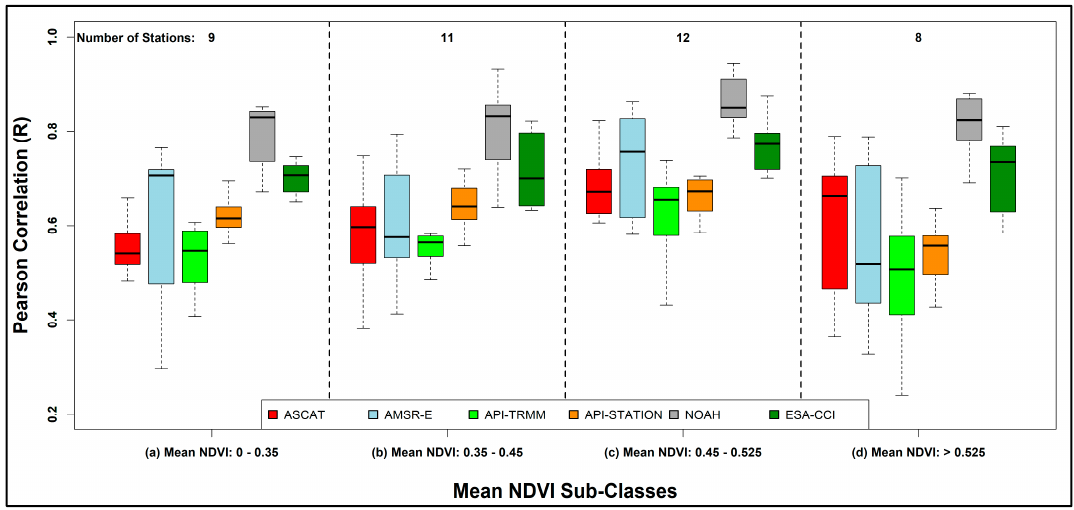
Figure 14. Correlations of soil moisture products under mean NDVI sub-classes